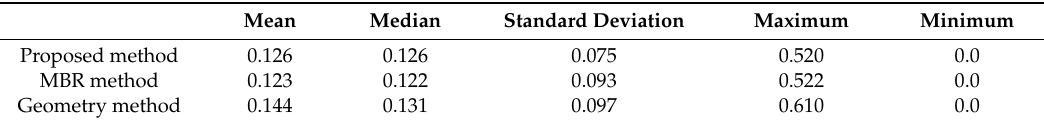
Figure 11. The distribution of surface distances of all buildings. The horizontal axis denotes the surface distances, and the vertical axis denotes the number of buildings. Table 3. Numerical evaluation of the compared experiments.